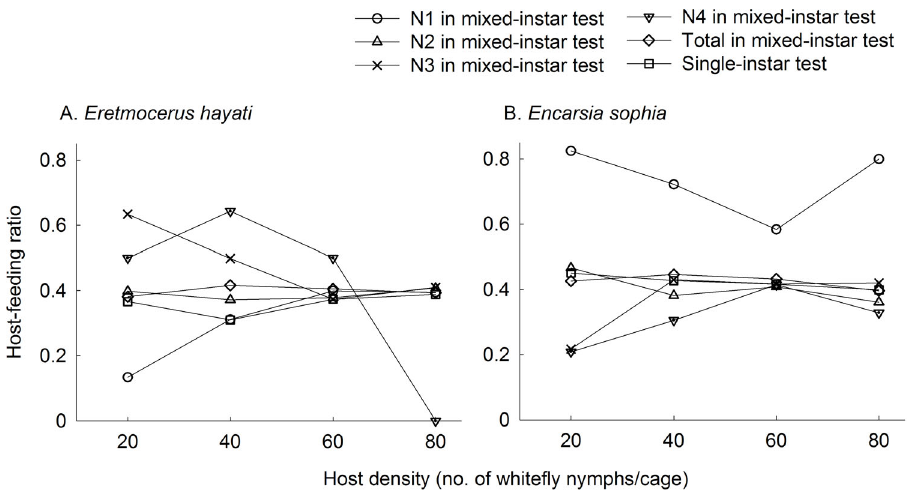
Figure 4. Mean proportion of accepted hosts fed upon by parasitoid in single-instar and mixed-instar host experiment. A, B: Proportion of hosts fed upon in 24h by 1 d-old females of Eretmocerus hayati or Encarsia sophia , respectively. An area of 3.5 cm 2 of a leaf on a potted tomato plant was covered by a clip cage. Host instars, N1, N2, N3 and N4 are first, second, third and early fourth instars, respectively. Single-instar tests were performed on N2 for Er. hayati , and N3 for En.